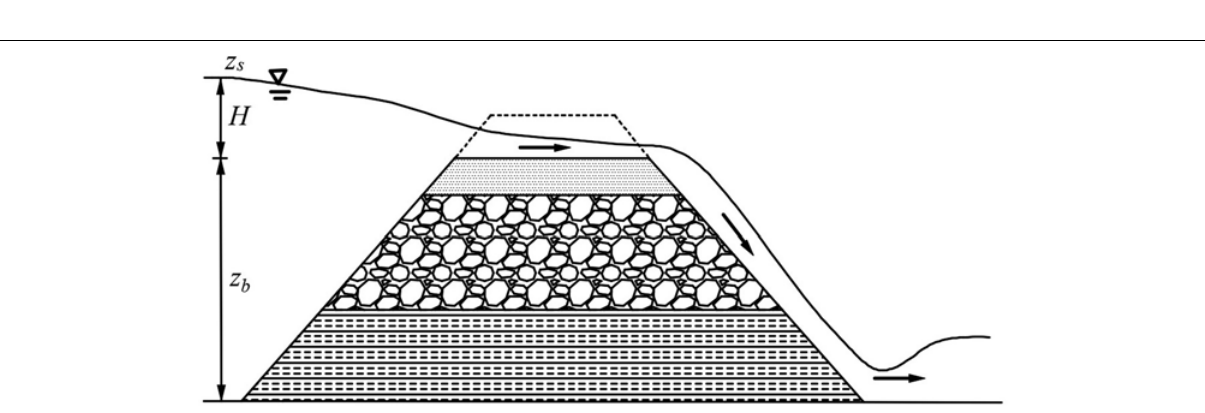
FIGURE 5 | Hydrodynamic condition of the